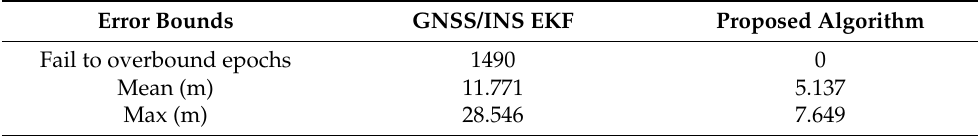
Figure 26. The error bounds and horizontal error of the EKF and the proposed algorithm in case 2. ( a ) The error bounds and horizontal error of the EKF. ( b ) The error bounds and horizontal error of the proposed algorithm. Table 8. The error bounds of the EKF and the proposed algorithm during the fault period.